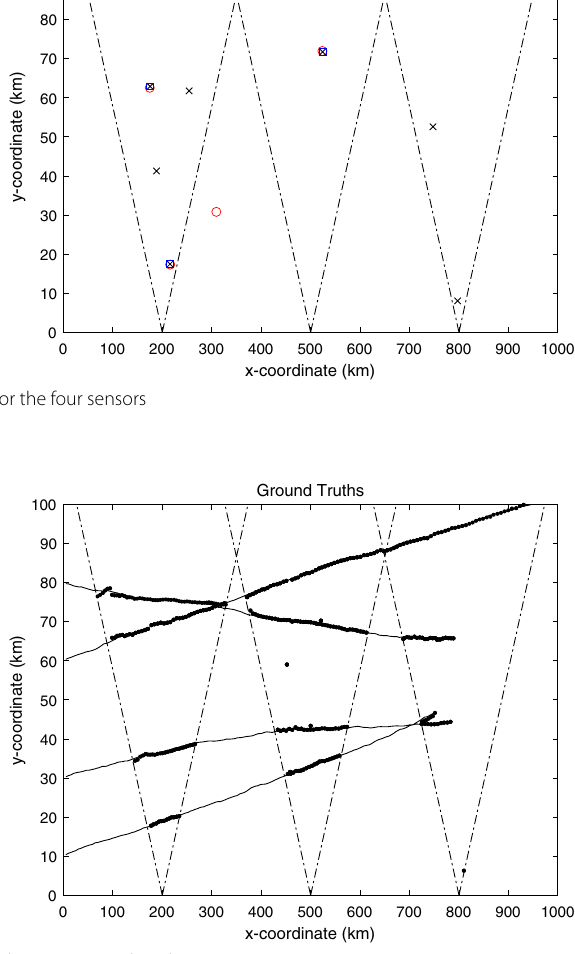
Fig. 3 Ground truths vs. estimated